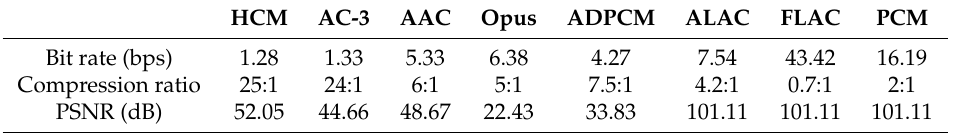
Table 3. Results for Linear dataset. Bit rates taken as close as possible to 50dB. HCM Opus